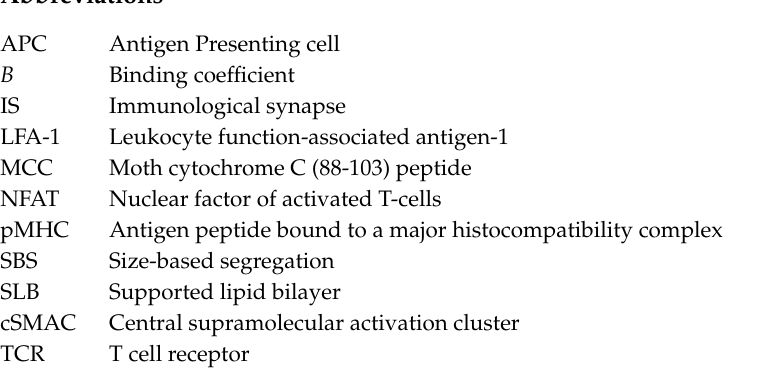
Figure S1: Time evolution of min ( cell K D ) during TCR and pMHC titration in the presence (solid lines) or absence (dashed lines) of F-actin centripetal transport. Figure S2: Time evolution of min ( cell K D ) with feedback from the binding coe ffi cient, B , in the presence or absence of centripetal transport of